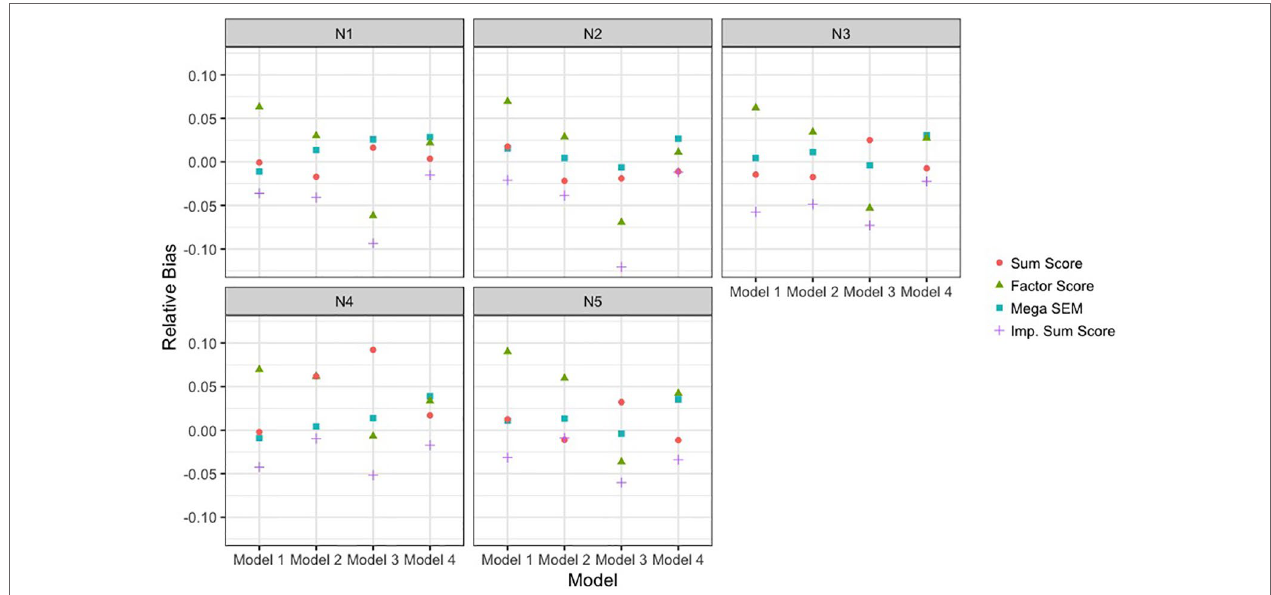
FIGUre 4 | Empirical bias of single-nucleotide polymorphism effect of each analysis approach relative to true effect size. Results are presented across the different data-generating models and the different sample size conditions detailed in Table 1 . The analysis approaches were sum score meta-analysis, factor score meta- analysis, mega-analysis with the bi-factor integration mode, and multiple imputation of the missing items. SEM, structural equation modeling; Imp.,